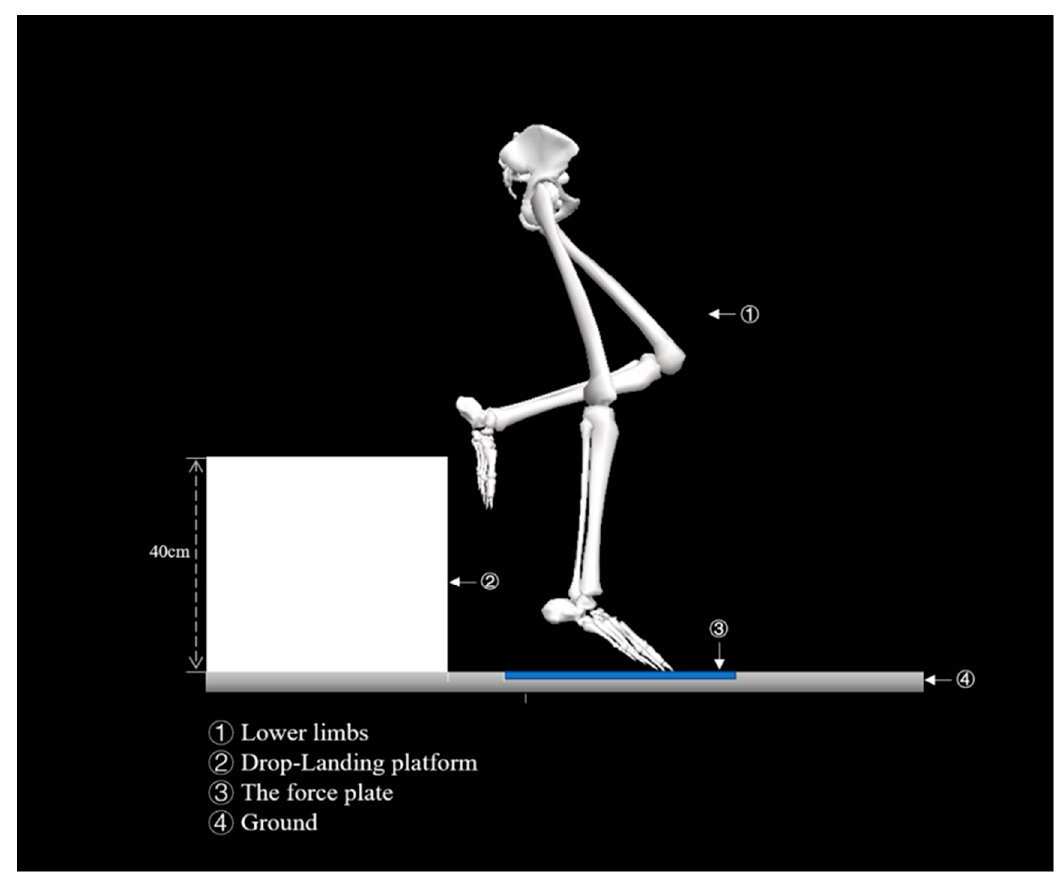
Figure 3. Experimental design for capturing the kinetic and kinematic data during the single-leg landing (SLL) phase for both normal shoes (NS) and bionic shoes (BS).